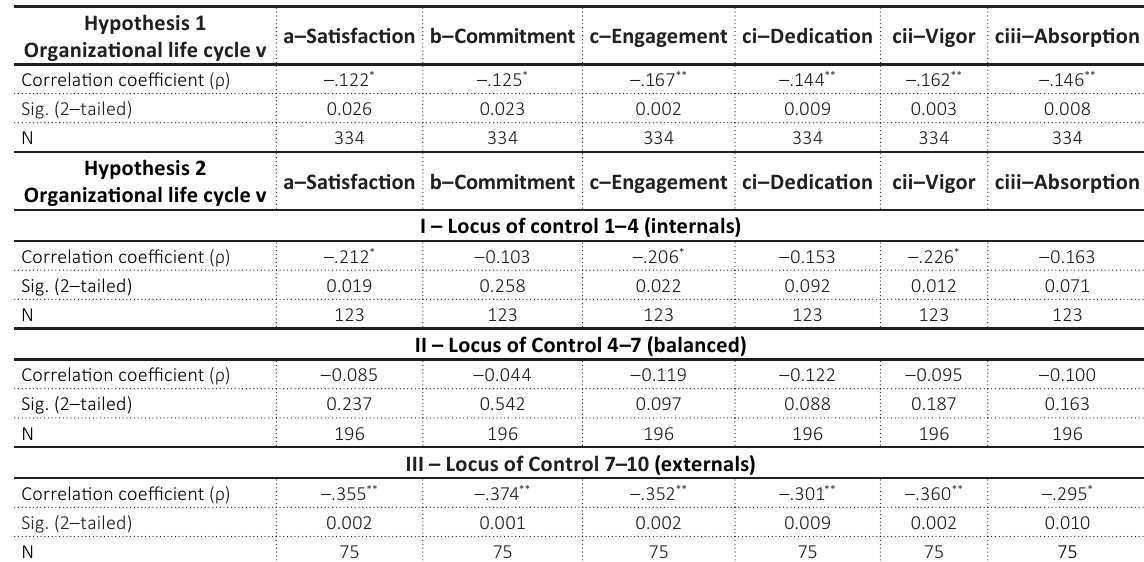
Table 1. Spearman’s rank-order correlation